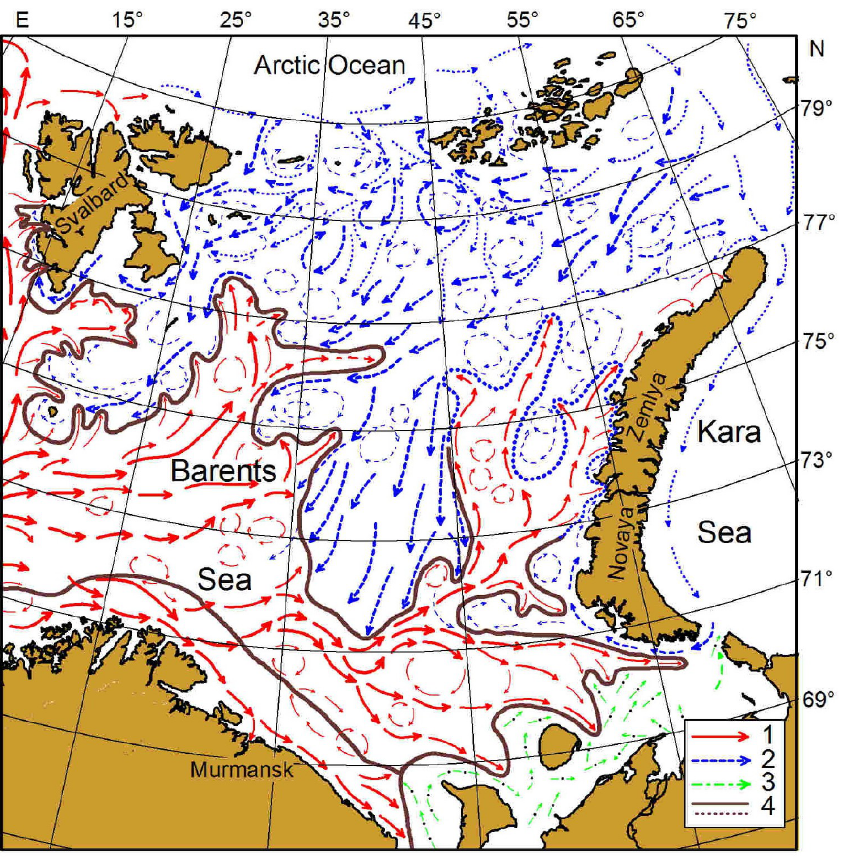
Figure 1. Study area, Barents Sea, and main currents: 1—warm flows; 2—cold flows; 3—White Sea and Pechora Sea flows; 4—boundaries of frontal zones [11,12].